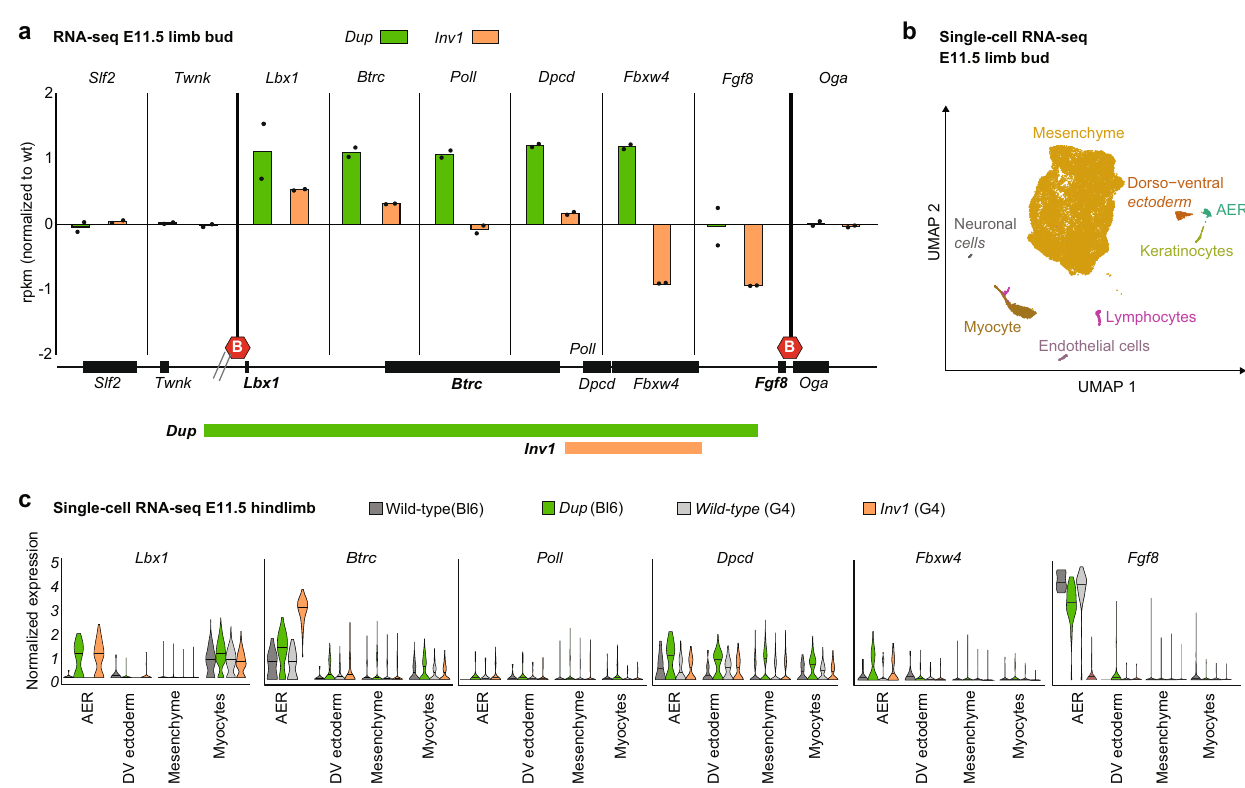
Fig. 4 | Dup and Inv1 chromatin rearrangements have an impact on gene expression. a Bar plot representing the rpkm value normalized to wild-type for genes in the Lbx1 and Fgf8 TADs and fl anking genes ( Slf2 and Twnk (centromeric), Oga (telomeric)) from RNA-seq data of homozygous Dup and Inv1 E11.5 limb buds. n =2biologicalreplicatespercondition.Schematicof thelocusshowstheposition ofthegenes,theTADboundaries(redhexagons)andthepartsincludedintheDup andtheInv1mutants.Wild-type Dup and Inv1 samplesareshowninblack,greenand orange, respectively. b Uniform manifold approximation and projection (UMAP)